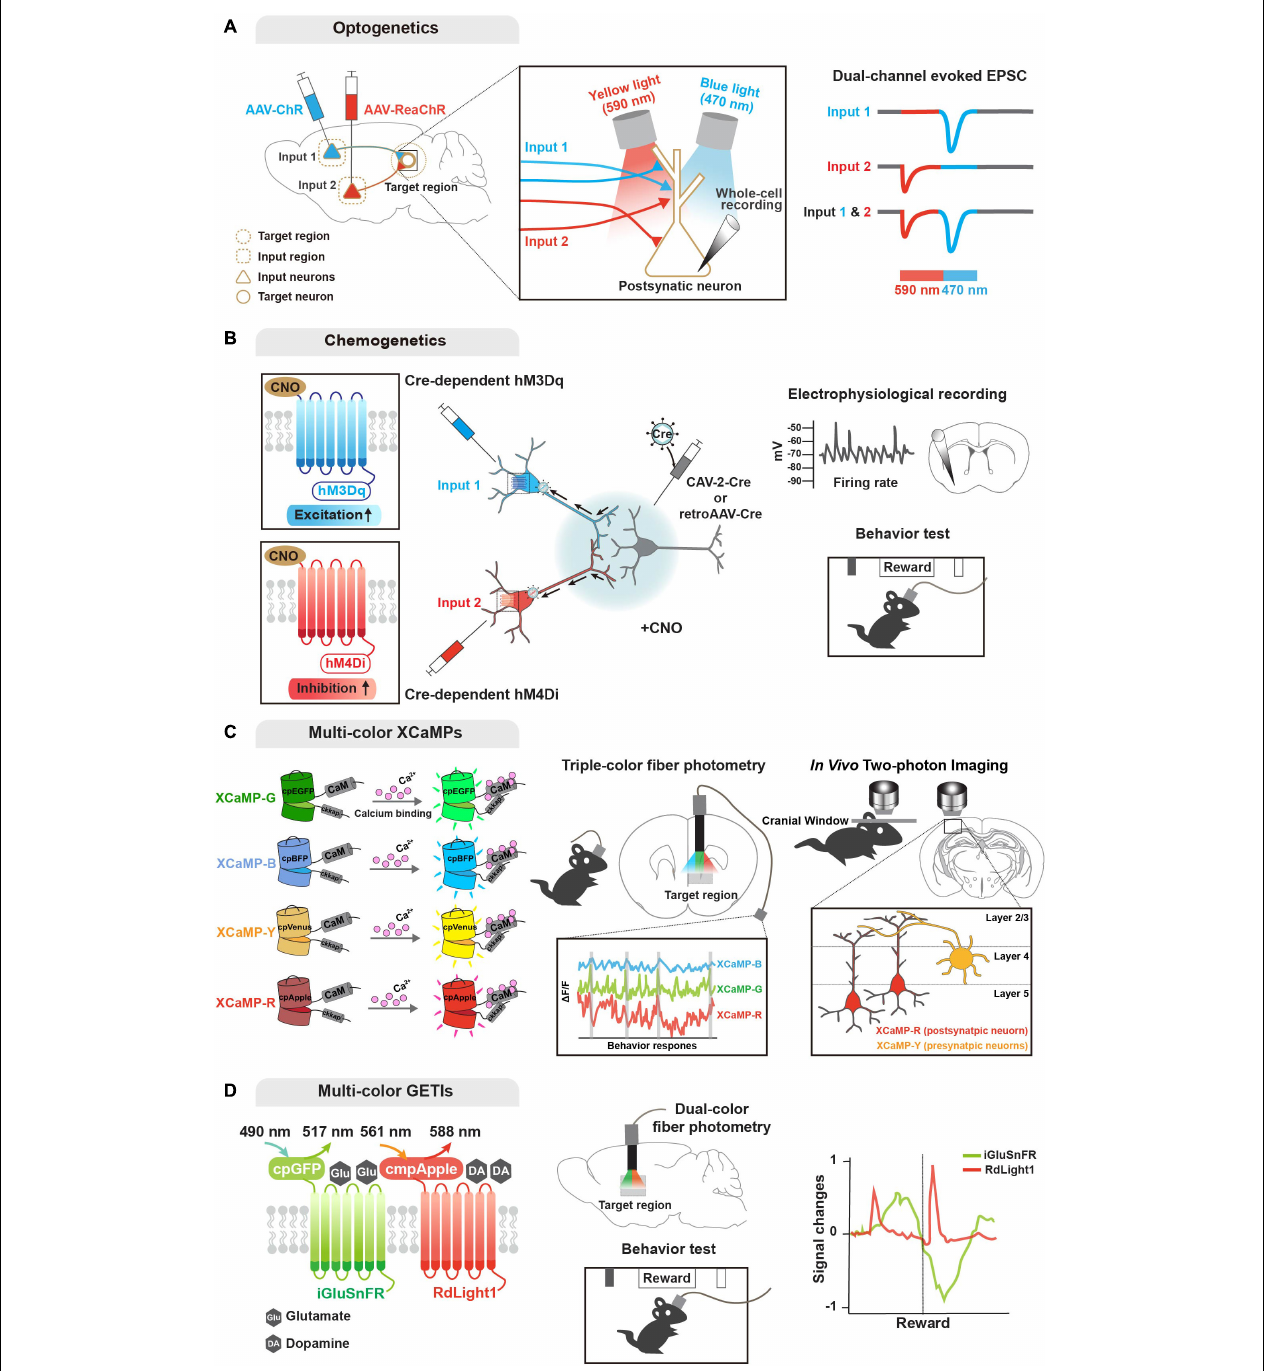
FIGURE 2 | Genetic tools for functional input convergence mapping. (A) Schematic illustration of dual-channel ChR-assisted circuit mapping (2CRAM). AAV expressing ChR2 and ReaChR are injected in different input regions/cell types and postsynaptic target cell recording after illumination (sequential stimulation of 590 and 470 nm lights) represents functional convergence. (B) Combinatorial strategy of DREADD and retrograde virus for input-selective manipulation. Input neurons are labeled with retrogradely delivered Cre using CAV-2 or retroAAV virus and Cre-dependent DREADDs (e.g., hM3Dq and hM4Di). Electrophysiological recording or behavioral analysis (e.g., reward seeking) after CNO ligand administration represents functional convergence. (C) Illustration of multi-color GECIs for convergent circuit mapping. Multi-color GECIs (XCaMP-G, -B, -Y, and -R) consist of a circularly permuted FPs and enable to monitor different cell-type activities in the target region of the freely behaving mice. Dual-color imaging for XCaMP-labeled pre- and postsynaptic neurons at a target region represents convergent circuit. (D) Illustration of multi-color GETIs for convergent circuit mapping. Dual-color imaging for co-expressing iGluSnFR and RdLight1 at the target region enable to monitor glutamate and dopamine releases during behavior test (e.g., reward